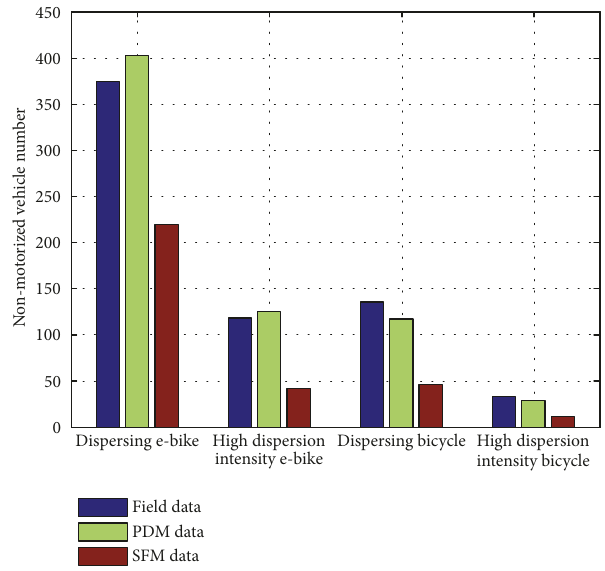
Figure 14: Number of dispersing nonmotorized vehicles at the Changji-Moyu intersection.